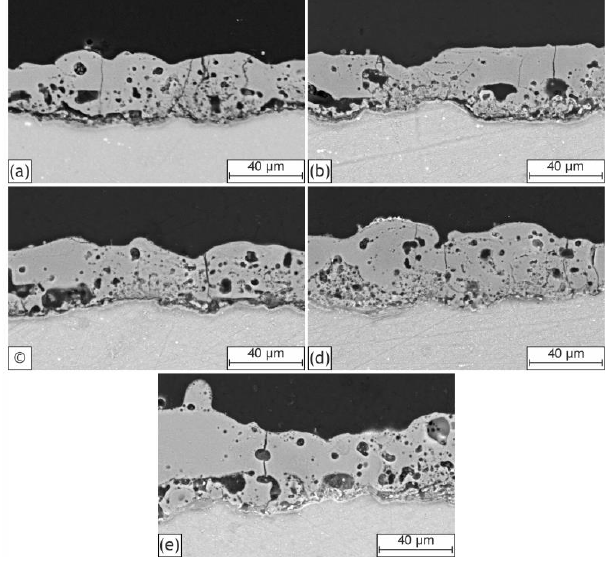
Figure 2. SEM images of coatings cross sections: H0 ( a ), H10 ( b ), H20 ( c ), H30 ( d ), H40 ( e ).